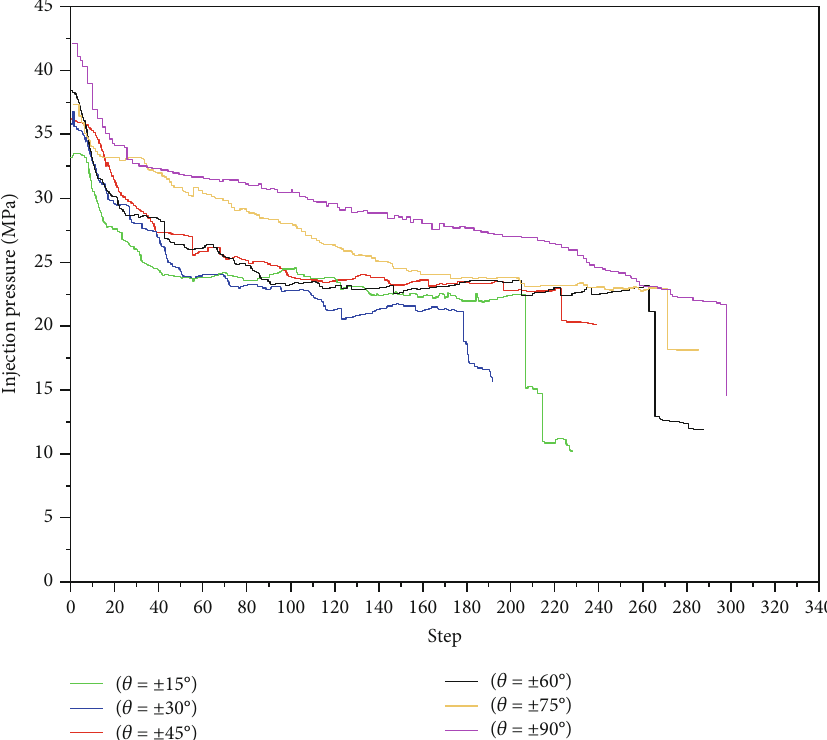
Figure 10: Injection pressure-step curves under di ff erent CCFs distribution direction.